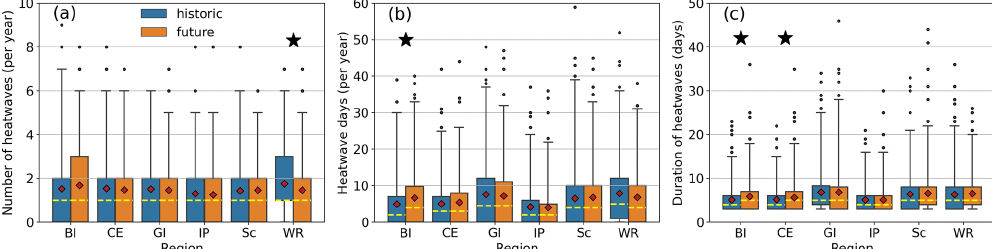
Figure 3. Properties of heatwaves in future (orange) and historic (blue) time slices in the six European regions: (a) number of heatwaves per year and region, (b) heatwave days per year, and (c) heatwave duration (in days) with a minimum heatwave lifetime of 3d. The significance of the difference in means between historic and future heatwaves per region has been tested with a two-sided Welch’s t test with a significance level of 0.05. Significantly different means are marked by a star on the top of the